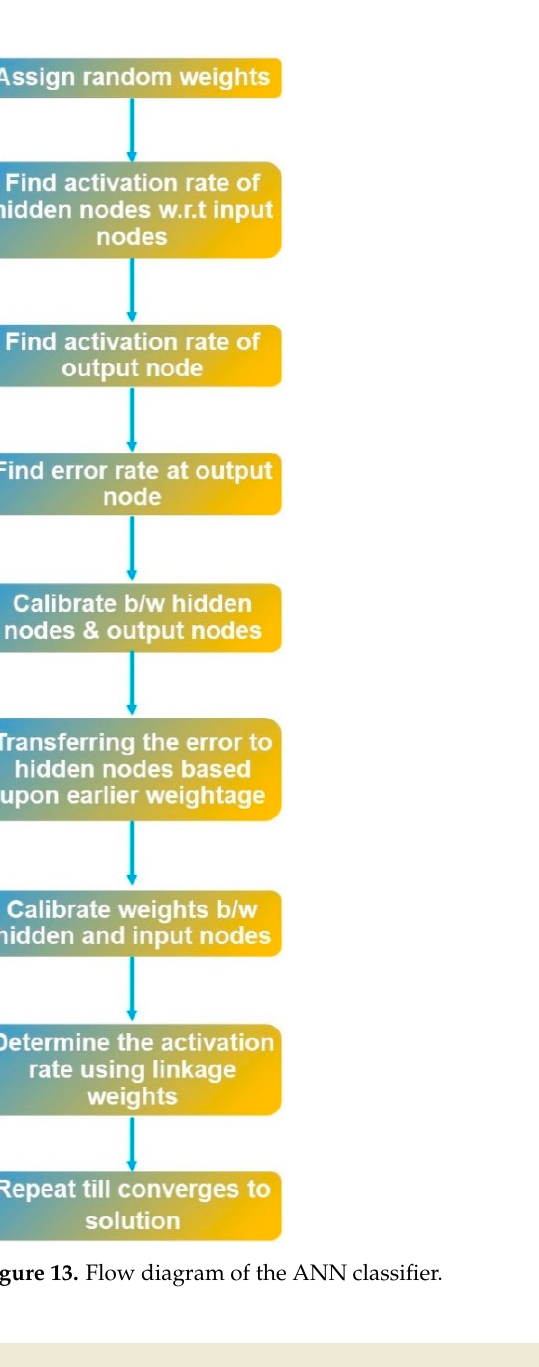
Figure 13. Flow diagram of the ANN classifier.